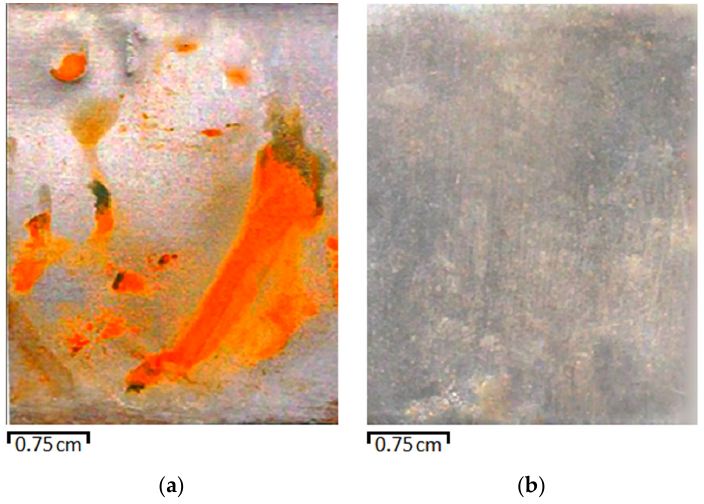
Figure 10. Appearance of steel samples after 12 h of exposure in 3% NaCl solution with and without ID addition at constant stirring at Т = 60 ° С : ( a ) 3% NaCl; ( b ) 3% NaCl + 0.01M (VS + BTA) + 1% Strodex. Table 6. The proportion of corroded steel surfaces after 12 h of exposure to 3% NaCl solution at T = 60 °C and constant stirring of the solution. Solution Corrosion Damage Rate, %